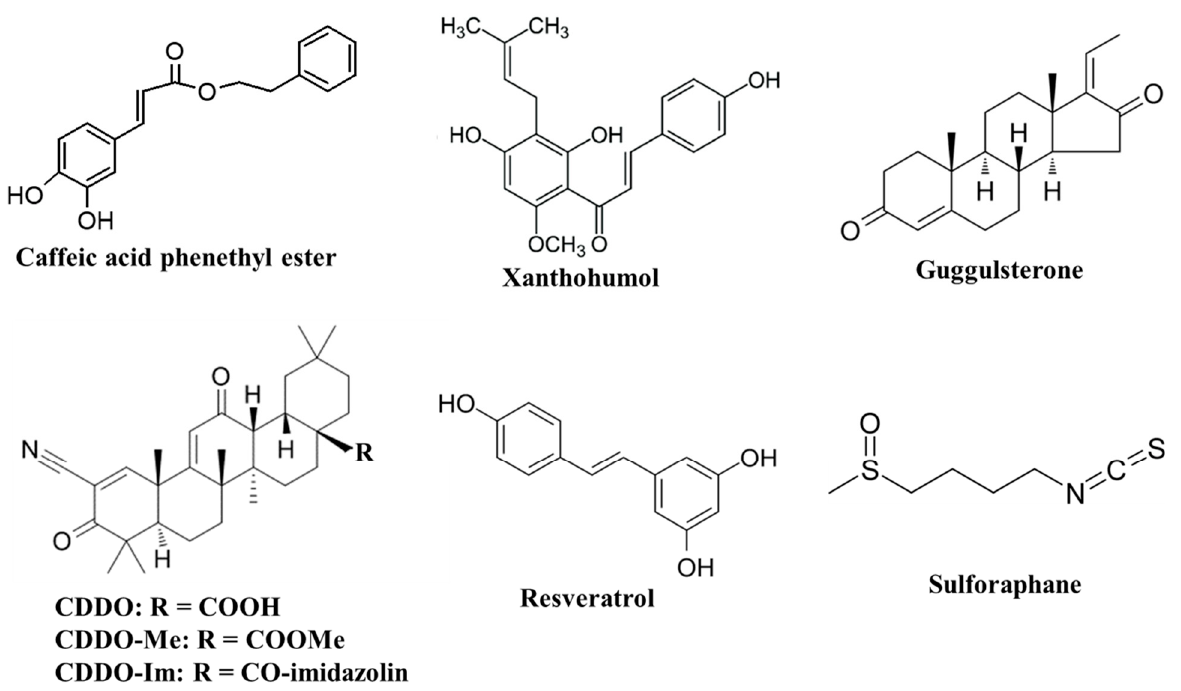
Figure 1. Structures of antioxidant phytochemicals with potential effects on autophagy and oxida- tive stress.